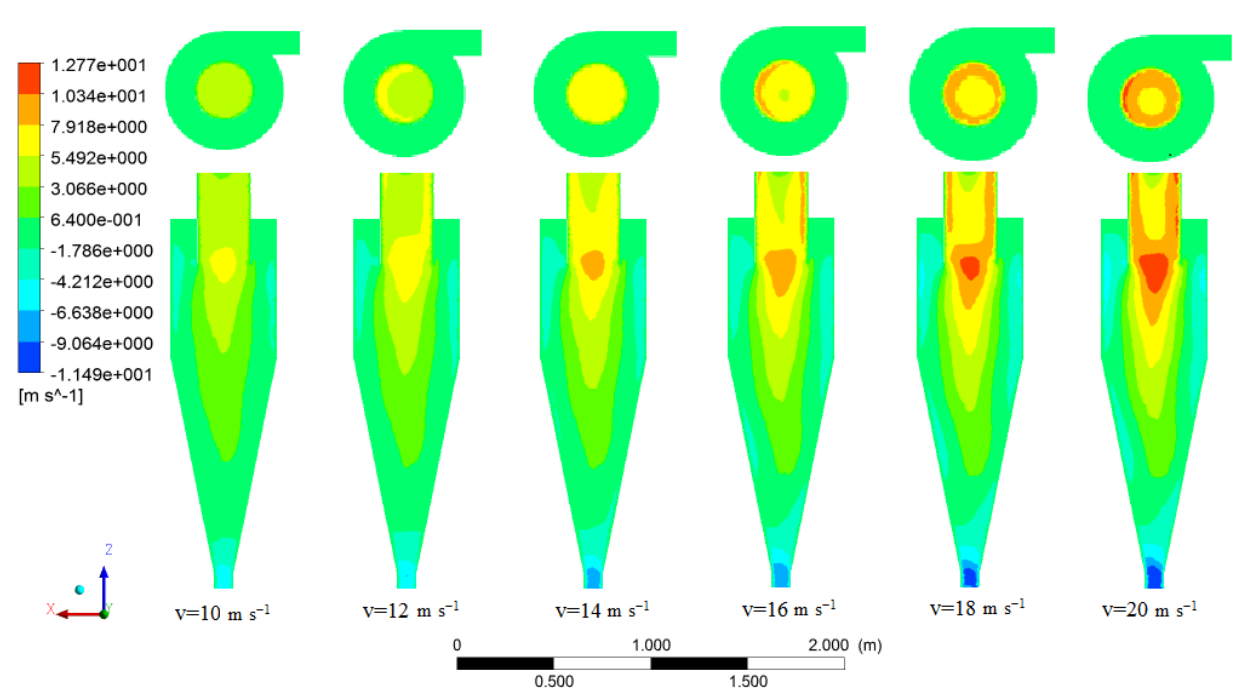
Figure 6. Axial velocity contours in various inlet velocities.